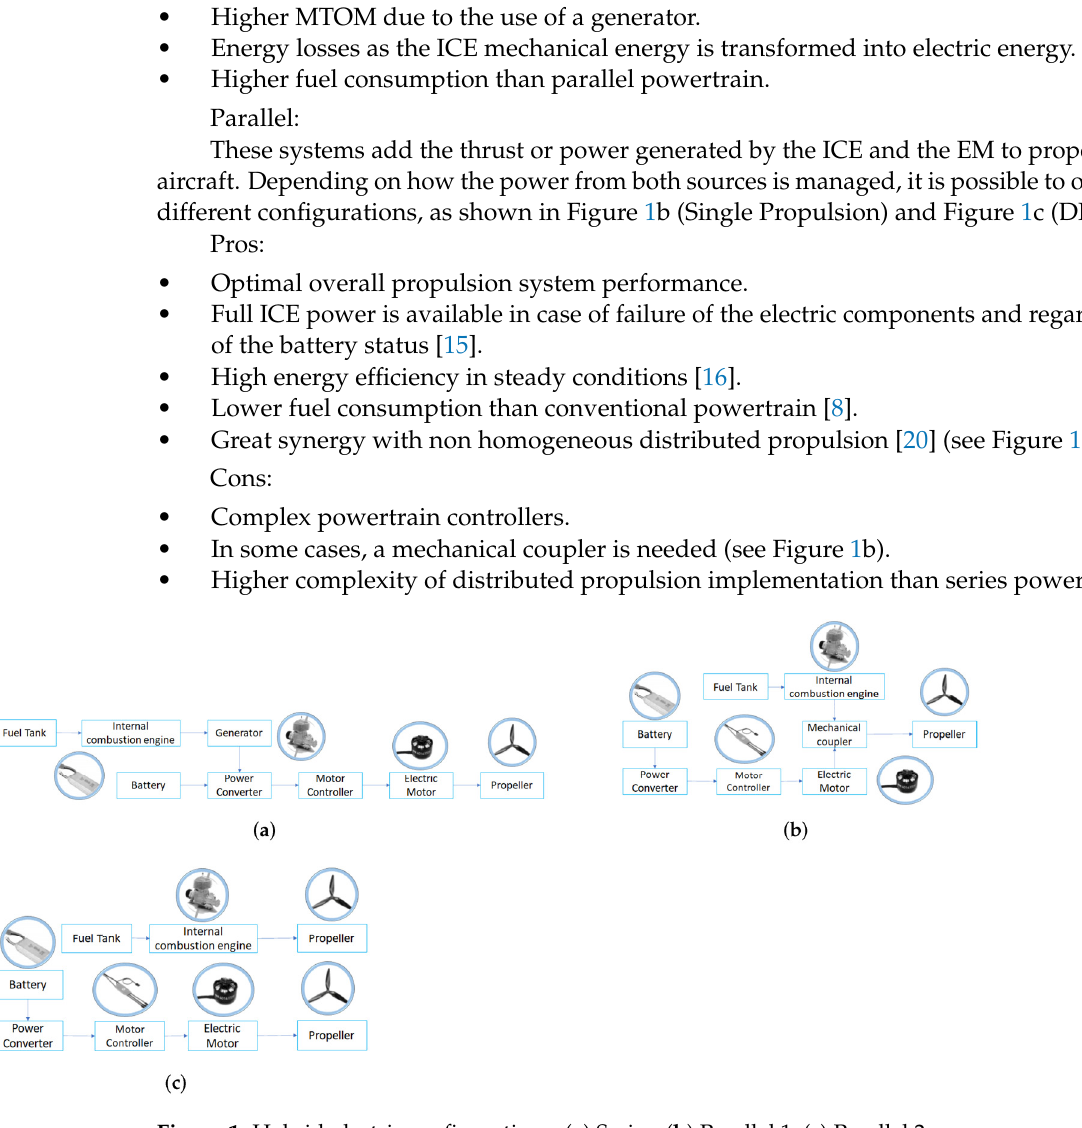
Figure 1. Hybrid-electric configurations. ( a ) Series; ( b ) Parallel 1; ( c ) Parallel